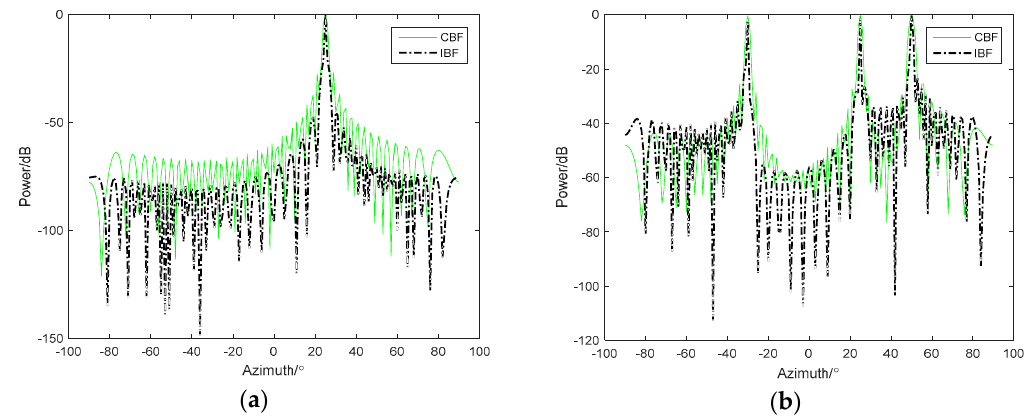
Figure 1. Comparison between conventional beamforming (CBF) and inverse beamforming (IBF) with ( a ) one target and ( b ) three equal energy targets.